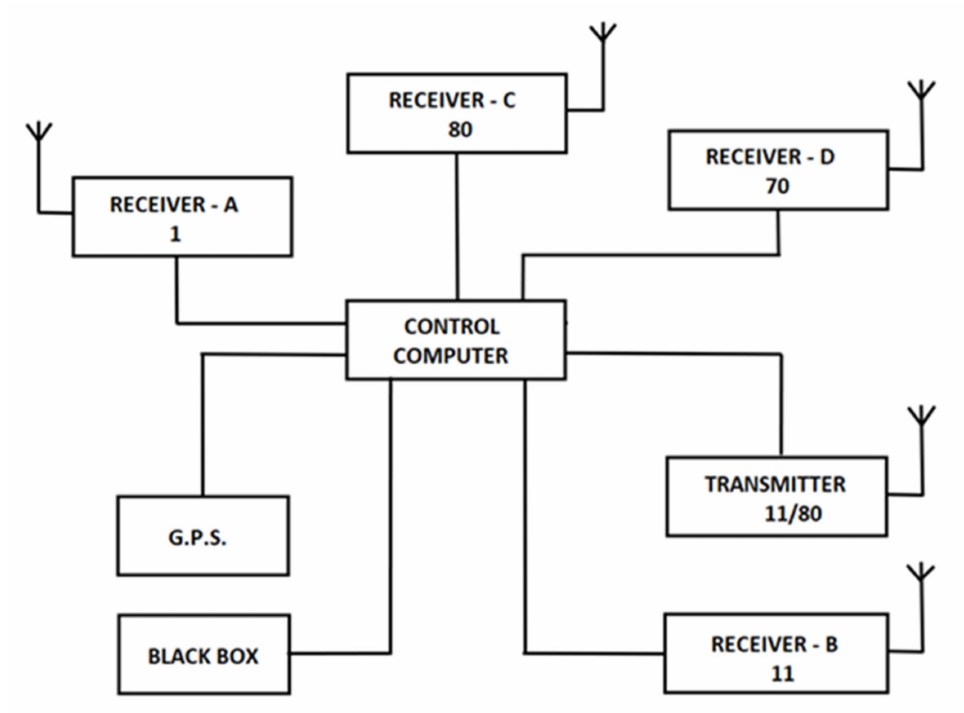
Figure 2. Block diagram of the first system proposed for installation on board (AVISOMEF). The ship is assumed to be in the first cell, which is located to the left of the grid depicted in Figure